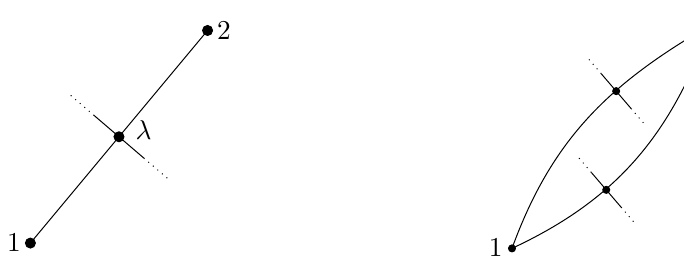
Figure 18. The operators φ ( x 1 ) and φ ( x 2 ) can create a φ 2 operator between them via the λφ 4 interaction. When φ ( x 1 ) and φ ( x 2 ) are boosted apart, this φ 2 operator gets smeared over the null cone, creating the detector L [ φ 2 ] . Right: when φ 2 ( x 1 ) and φ 2 ( x 2 ) are boosted, the same mechanism can create a pair of detectors L [ φ 2 ] L [ φ 2 ]